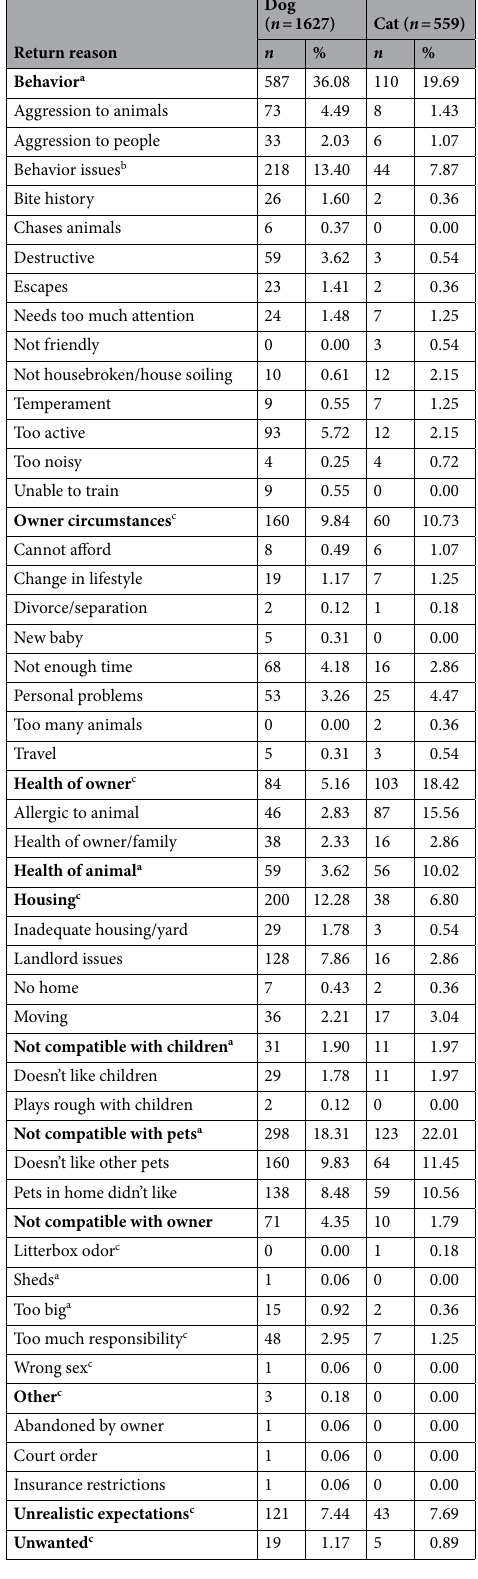
Table 3. Reasons for returned adoptions including first return only for multi-return animals ( n = 2186). a Animal-based return reason. b Includes multiple behavioral issues. c Owner-based return